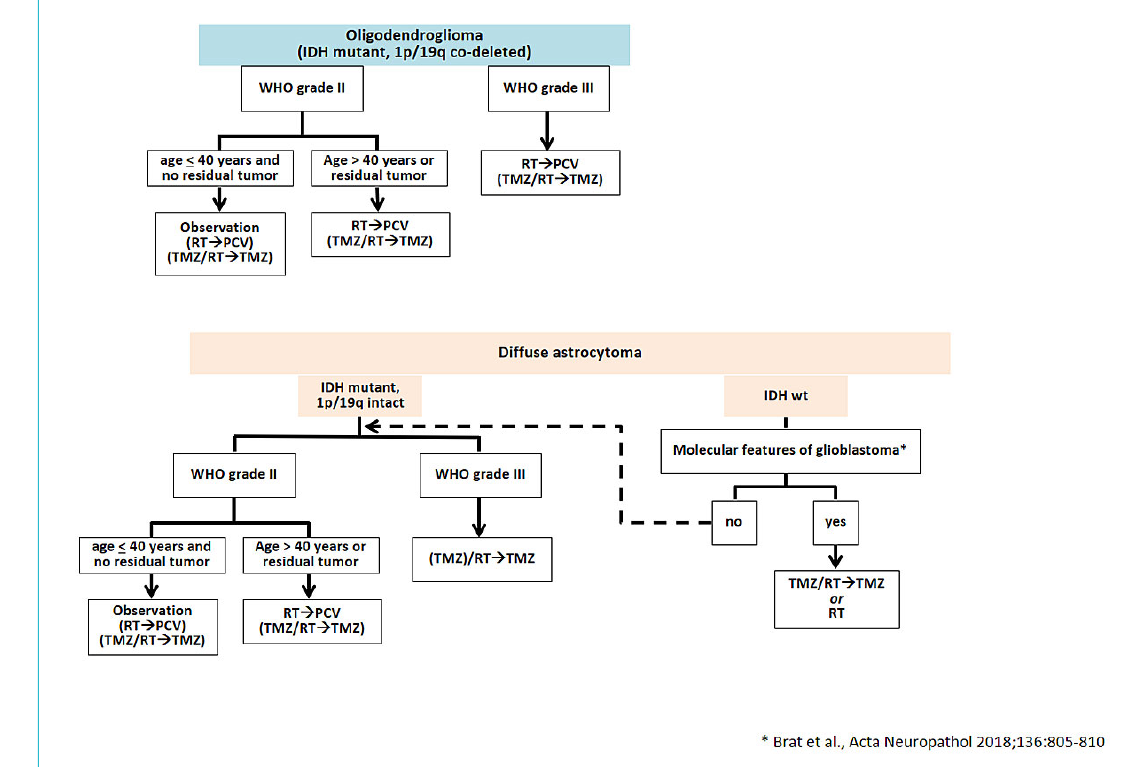
Figure 3: Therapeutic options for patients with WHO grade II and III diffuse gliomas. Alternative treatment options which may considered on an invididual base are indicated in brackets. The dotted arrow indicates that for IDH wild-type tumours without molecular features of glioblastoma, the same therapeutic approach as for IDH mutant tumours should be considered.IDH = isocitrate dehydrogenase; WHO = World Health Organization; RT = radiotherapy; TMZ = temozolomide; PCV = procarbazine; CCNU =